Question: What caption would you write for this figure?
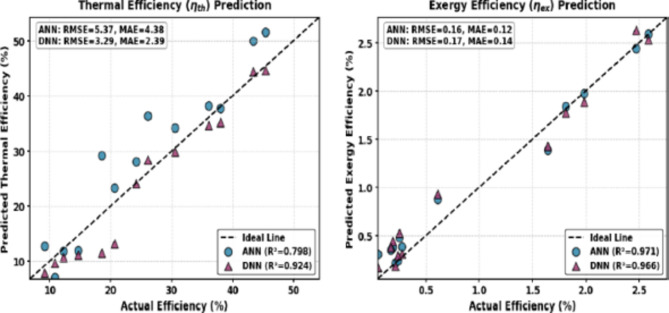
Answer: Scatter plots for thermal and exergy efficiencies.